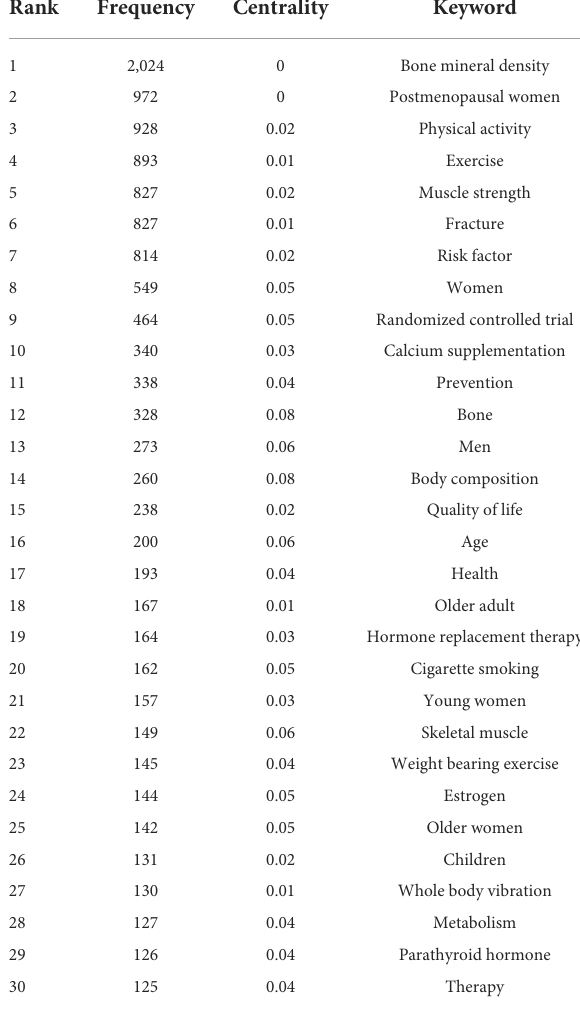
TABLE 6 The top 30 keywords of osteoporosis rehabilitation-related studies that were published from 1965 to